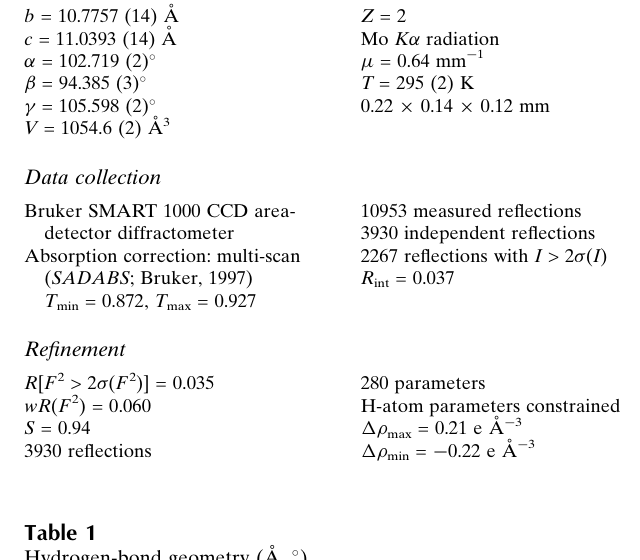
Hydrogen-bond geometry (A˚ , (cid:1)